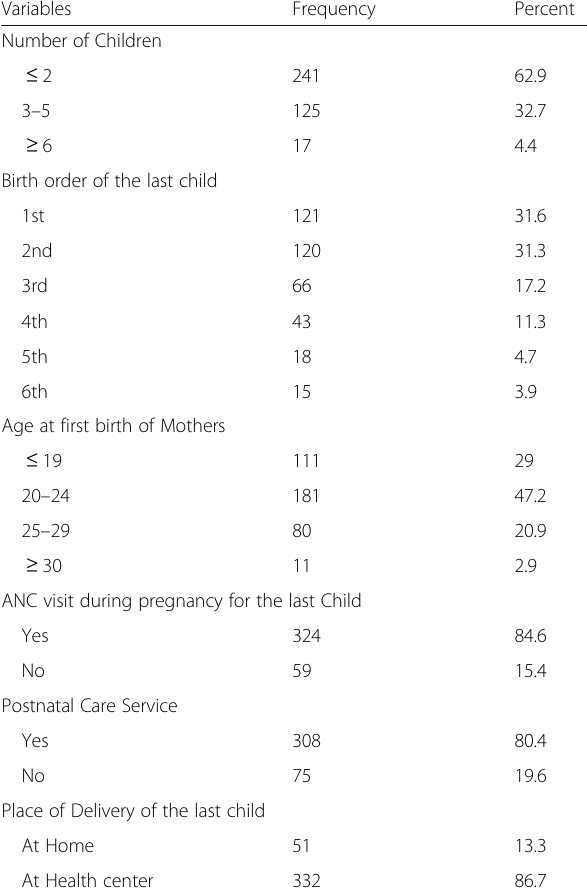
Table 2 Reproductive history of the Respondents; Tigray Region, Ethiopia, May,